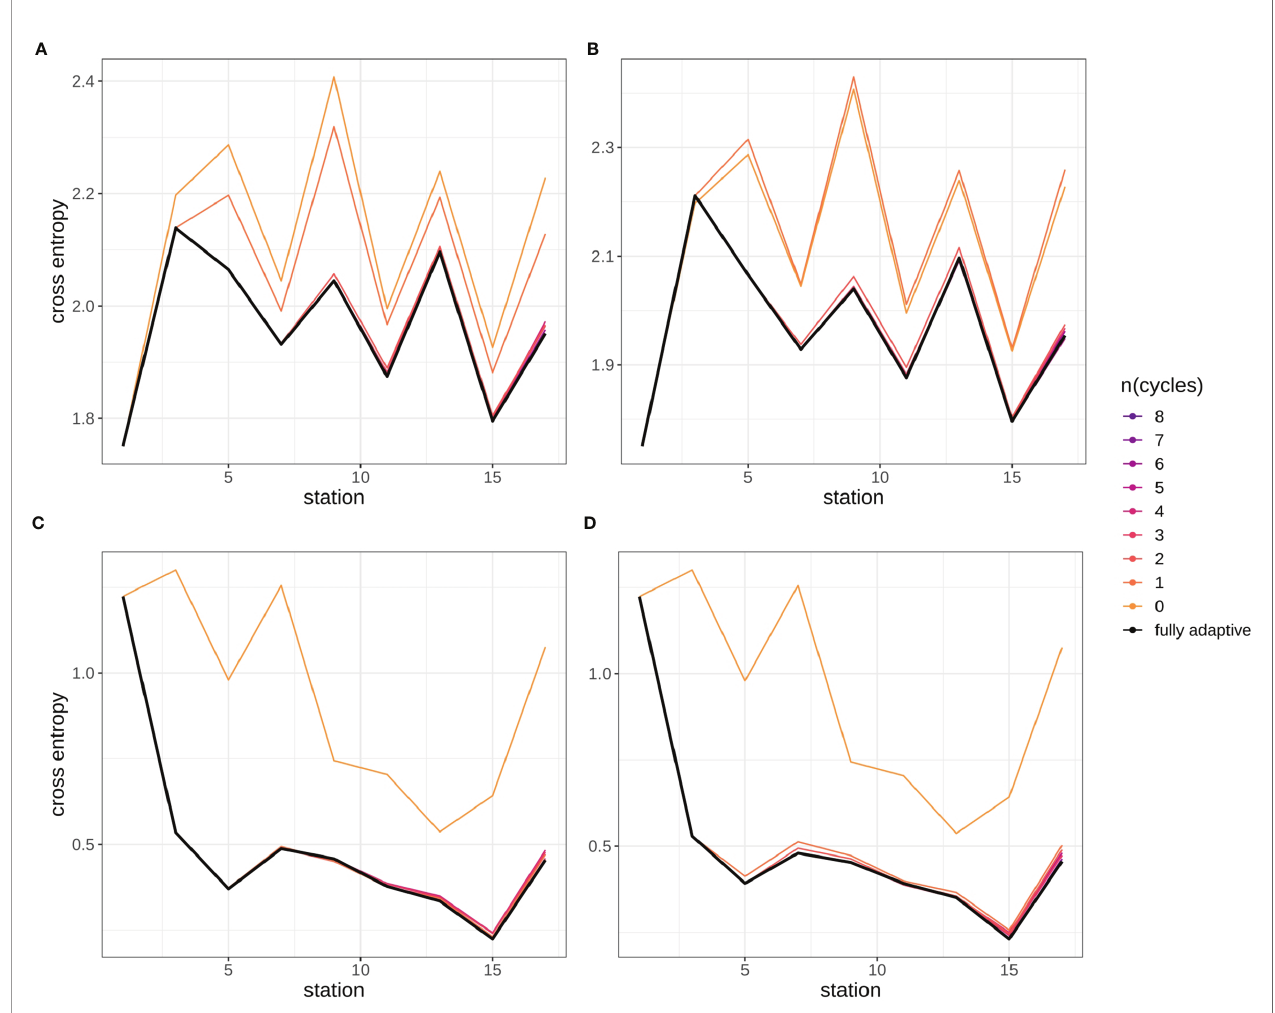
FIGURE 9 | Cross-entropy trajectories for different modes of adaptation using the DOC. Solid black line represents weighted mean of the fully-adaptive implementation, grey area denotes the corresponding weighted standard deviation. Colored solid and dashed lines represent weighted mean and weighted standard deviation of less-adaptive implementations (denoted by the number of adaptation cycles). (A) : September survey, fi rst replicate, (B) September survey, second replicate; (C) : December survey, fi rst replicate, (D) : December survey, second replicate. Replicates differ in the random selection of images for training-set updates and random parameter initializations of models before training (see Case Studies – North Sea Surveys ). Trajectories for all nine adaptation modes are shown in Figure SI XI/5